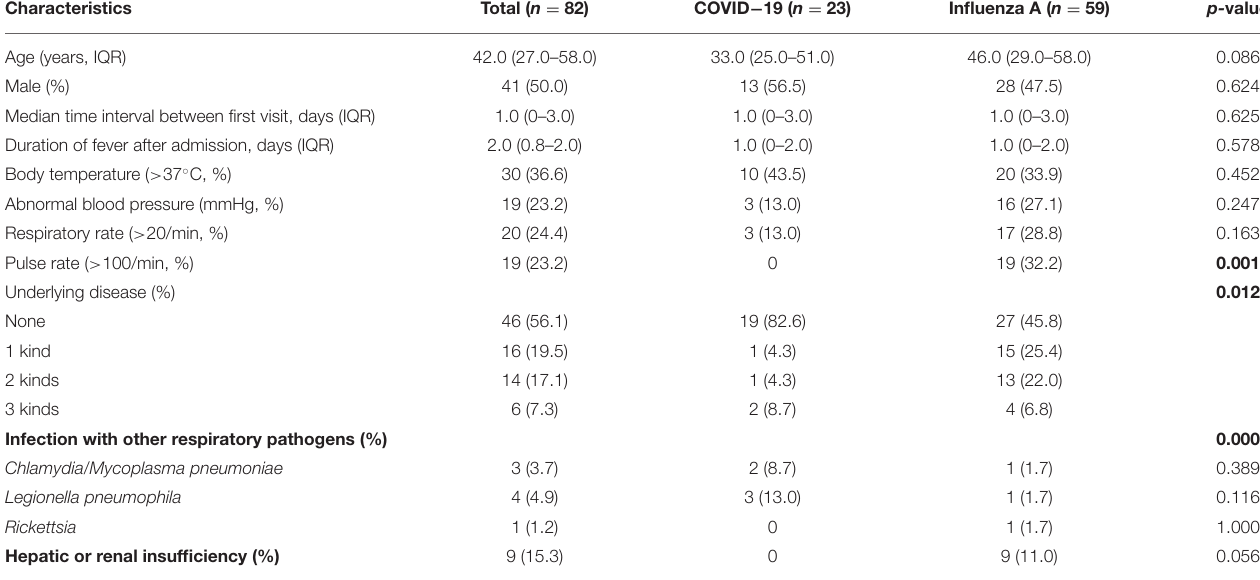
TABLE 1 | Characteristics of patients with COVID-19 or influenza A.